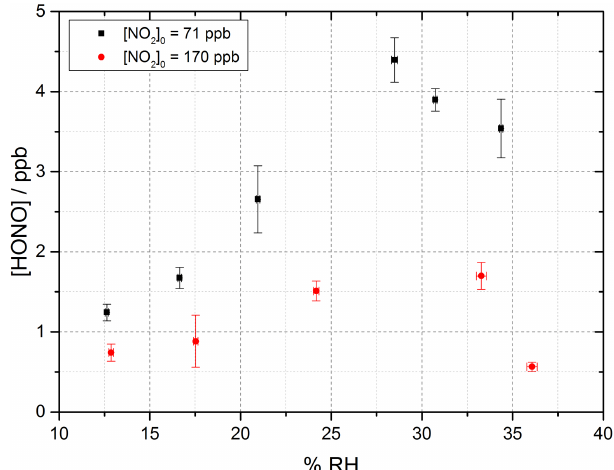
Figure 7. RH dependence of HONO production from illuminated TiO 2 aerosol surfaces at 295K in N 2 at 71 (black) and 170 (red)ppb initial NO 2 mixing ratio. The aerosol surface area density was kept constant at (1.59 ± 0.16) × 10 − 2 m 2 m − 3 with a photon flux of (1.63 ± 0.09) × 10 16 photonscm − 2 s − 1 and an illumination time of 52 ± 2s. The error bars represent 1 σ